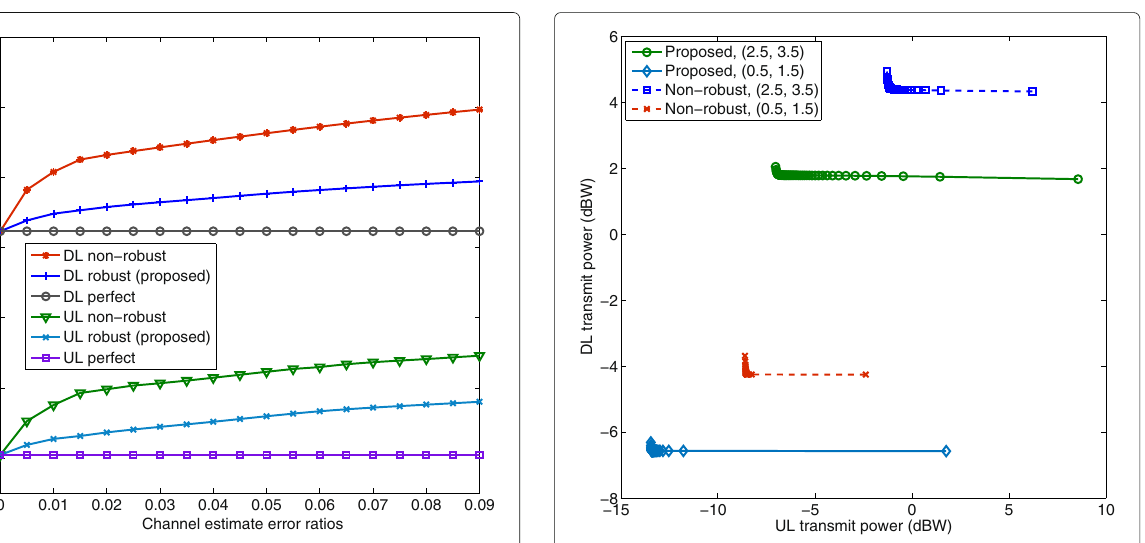
Fig. 4 Trade-off region between UL and DL transmit powers for different